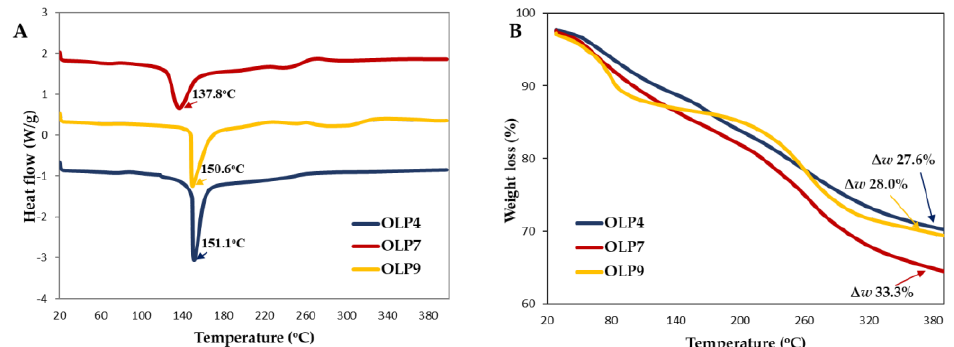
Figure 4. Thermal stability properties of polysaccharides from okra leaves (OLPs). DSC ( A ) and TGA ( B ) curves. ∆ w represents % weight loss.